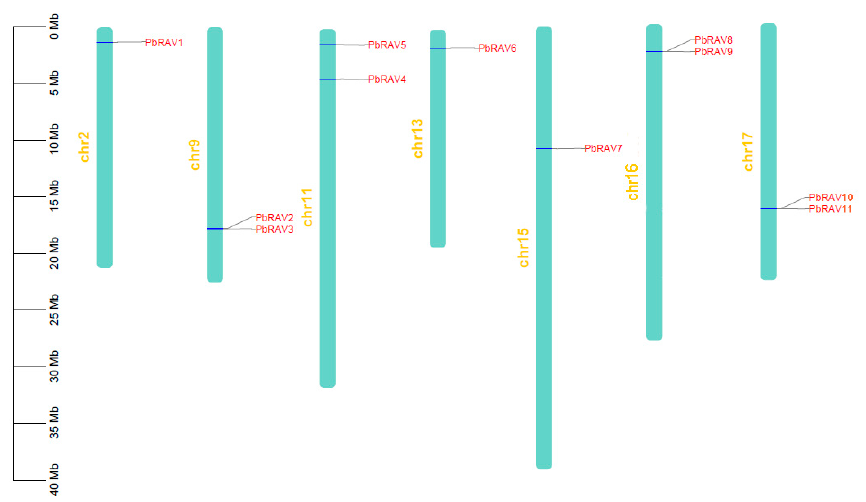
Figure 3. Chromosomal distribution of PbRAV genes drawn using MapChart v2.2. Scale represents chromosome length: 0 – 40 Mb.